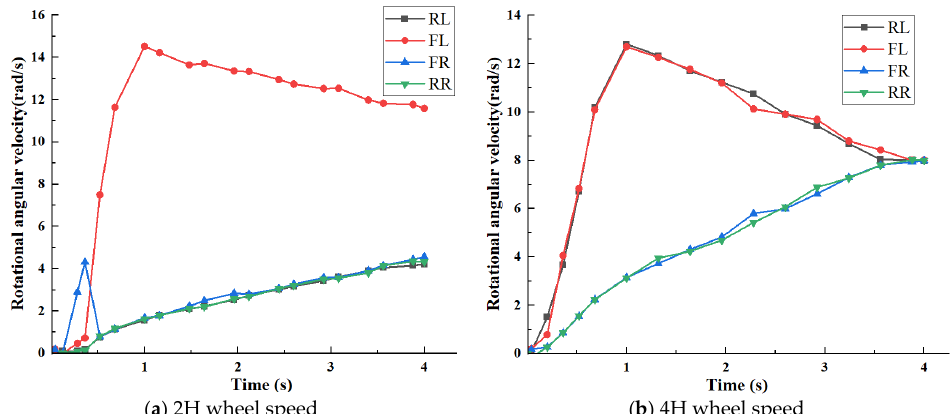
Figure 12. Simulation test results of opposed pavement.